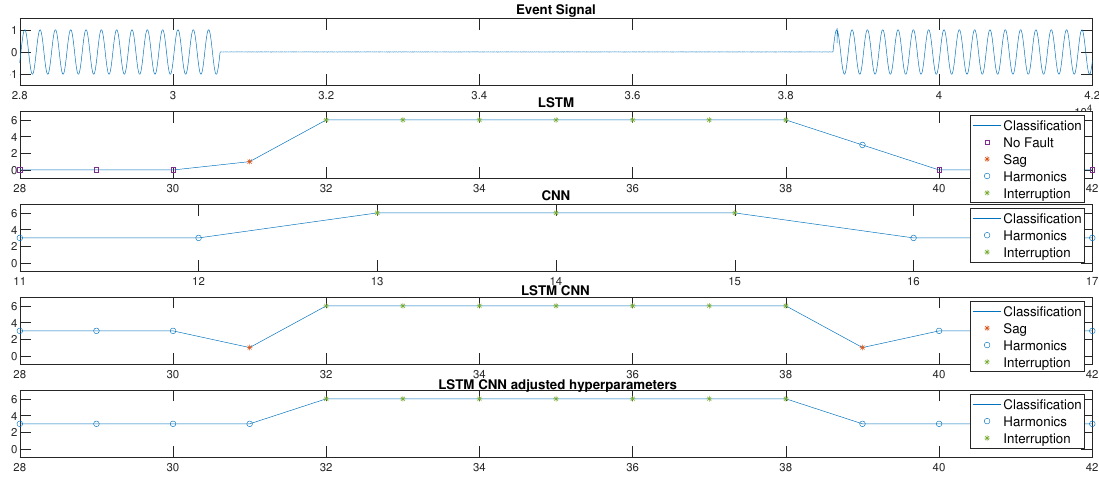
Figure 14. Voltage signal with an interruption measured on the test bench (top plot). From top to bottom, the classification performances of each architecture: LSTM, CNN, LSTM-CNN and the LSTM-CNN with adjusted hyperparameters.